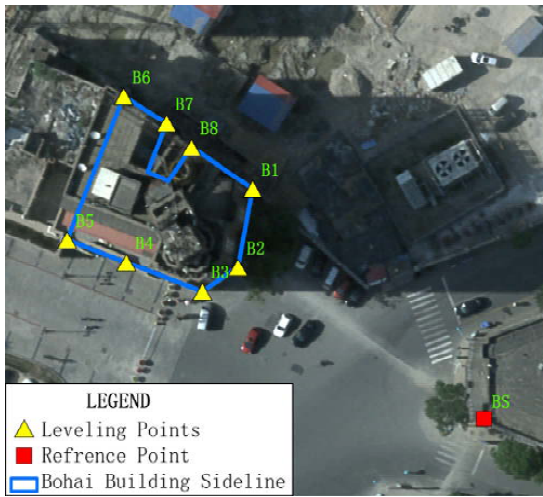
Figure 5. Locations of Leveling points and reference points for the displacement monitoring of the Bohai Building using leveling technique, with aerial ortho ‐ photo of 0.2 m as background.